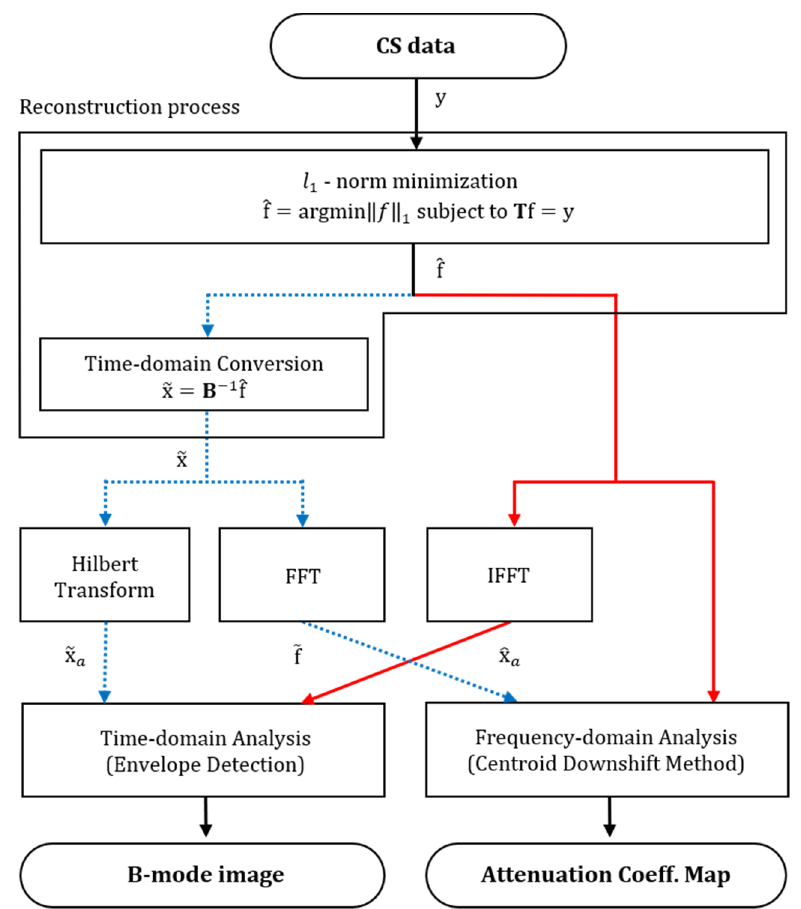
Figure 2. Summary of the framework for temporal and spectral analysis of compressed sensing data. The blue dotted line illustrates the traditional approach, while the red solid line depicts the approach devised in this study.